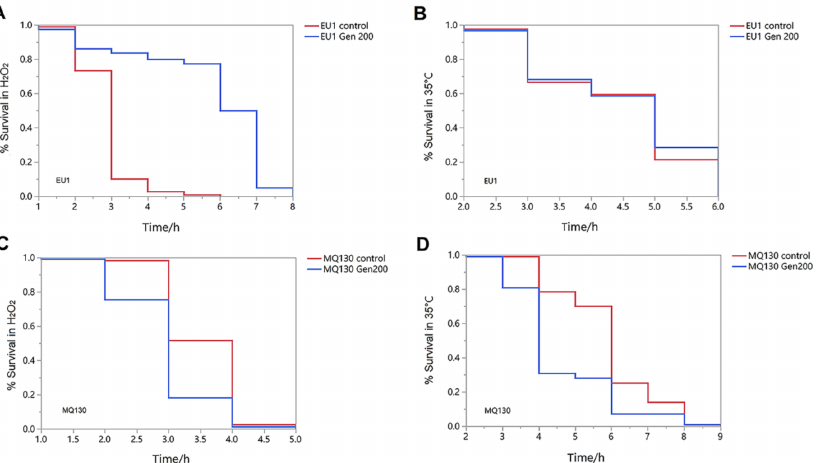
Figure 4. The effect of 200 µ M genistein on the survival rate of EU1 and MQ130 mutant nematodes at L4 under H 2 O 2 and 35 ◦ C conditions. ( A ) The effect of genistein on the survival rate of EU1 mutant exposed to H 2 O 2 -induced oxidation. ( B ) The effect of genistein on the survival rate of EU1 mutant exposed to heat shock at 35 ◦ C. ( C ) The effect of genistein on the survival rate of MQ130 mutant exposed to H 2 O 2 -induced oxidation. ( D ) The effect of genistein on the survival rate of MQ130 mutant exposed to heat shock at 35 ◦